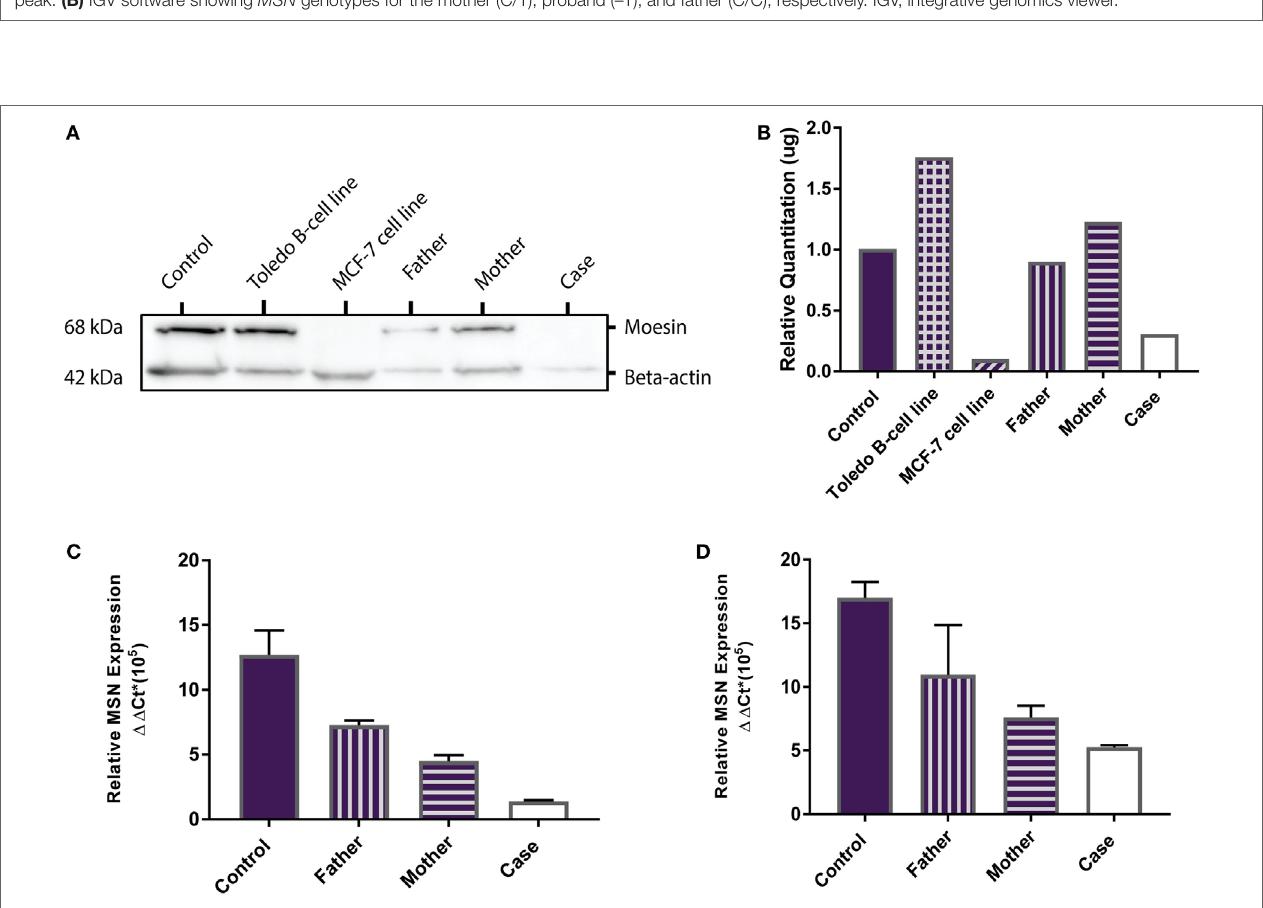
FIGURe 1 | Validation of the R171W MSN mutation in family members. (a) Sanger sequence and pedigree tree diagram for the missense MSN C > T mutation. P, proband; F, father; M, mother; S, sister. Mother is heterozygous C/T marked by a double blue and red peak and proband is hemizygous –/T marked by a single red peak. (B) IGV software showing MSN genotypes for the mother (C/T), proband (–T), and father (C/C), respectively. IGV, integrative genomics